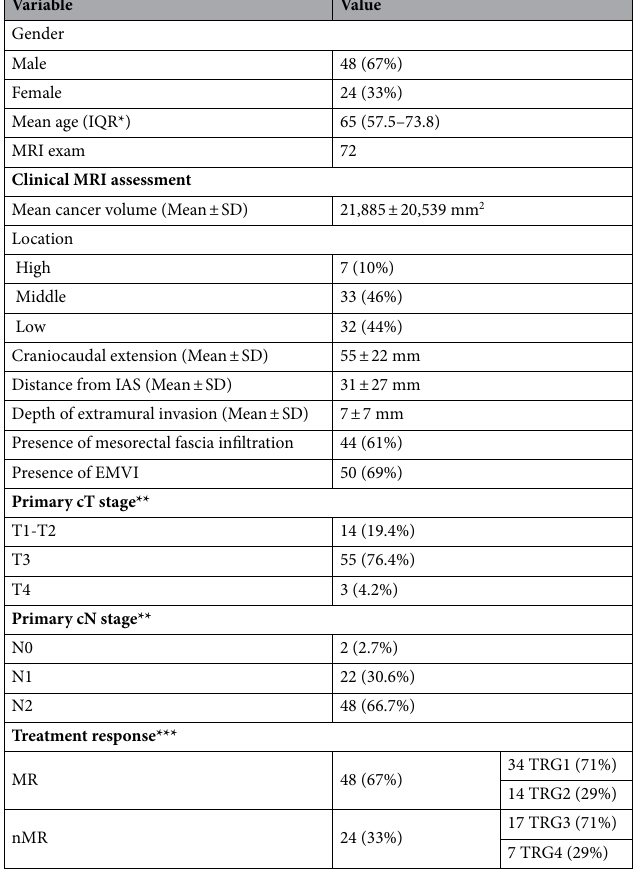
Table 2. Descriptive baseline characteristics of included patients (n = 72). *IQR Inter-Quartile Range; SD Standard Deviation; IAS Internal Anal Sphincter; EMVI Extramural Vascular Invasion; MR Major Pathological Response; nMR non-Major Pathological Response. **Assessed with MRI and derived from clinical MRI reports in the hospital’s patient database. ***Assessed according to Mandard Tumor Regression Grade (TRG) system on surgical specimen after neoadjuvant treatment in 69/72 patients. In three patients, a sustained complete clinical response (with repeated negative MRI examinations and endoscopy with or without biopsy) was considered surrogate for a complete response; the follow-up (mean ± SD) was 47 ± 11